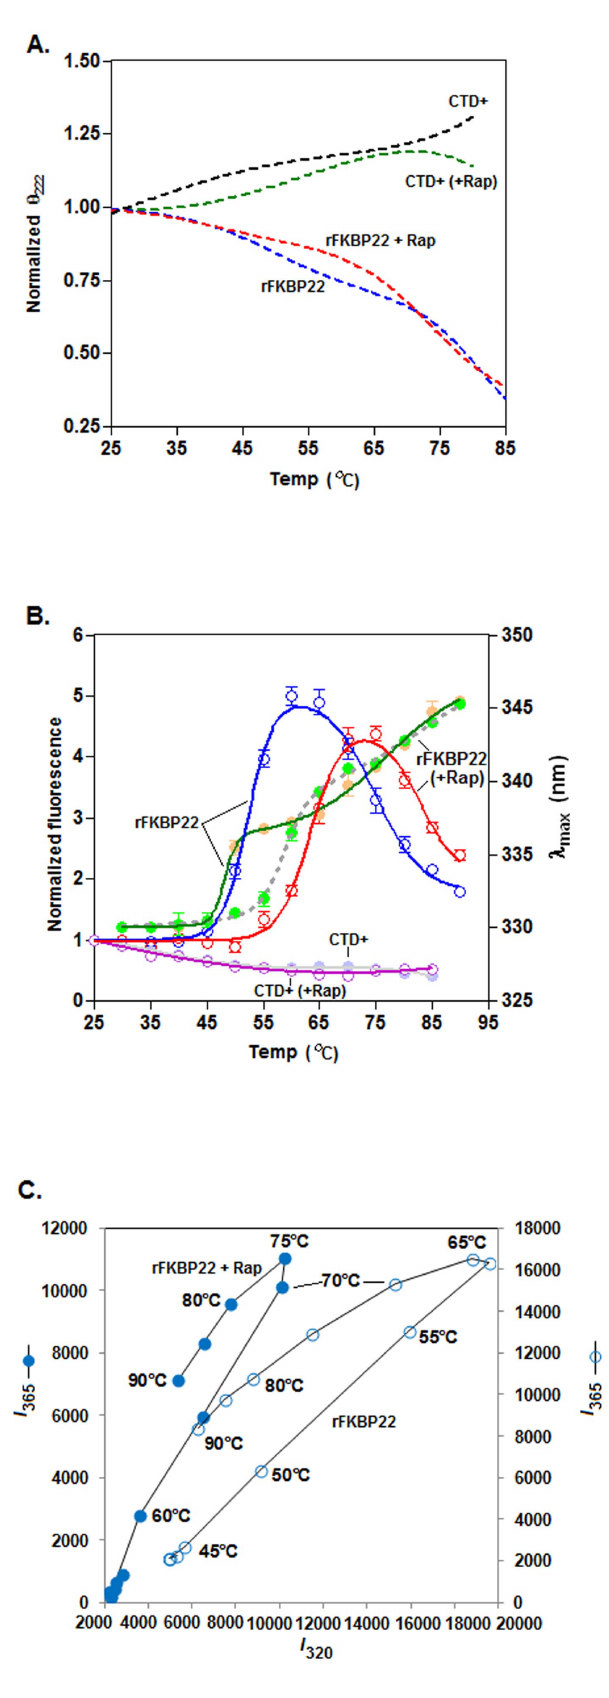
Figure 5. Thermal unfolding of of rFKBP22 and CTD + in the absence and presence of rapamycin. (A) The h 222 (ellipticity at 222 nm) values, obtained from the CD spectra of the indicated proteins (saturated with or without Rap) at 25 u –85 u /95 u C (Figures S7A–7D), were normalized with respect to that of the same at 25 u C. The resulting normalized h 222 values were plotted versus the related temperatures. All lines through the CD values are the best-fit curves. (B) The intrinsic Trp fluorescence intensity values at 330 nm (for rFKBP22 bound with or without rapamycin) and at 347 nm (for CTD + saturated with or without rapamycin) were similarly calculated from the Trp fluorescence spectra (Figures S7E–7H), normalized and plotted against the corresponding temperatures. The l max values associated with the rapamycin-equili- brated rFKBP22 and rFKBP22 at 25 u –90 u C were extracted too from the Trp fluorescence spectra (mentioned above) and plotted against the relevant temperatures. All lines through the fluorescence intensity or l max values are the best-fit curves. (C) Phase diagrams showing the unfolding of the indicated proteins at 25 u –90 u C. I 320 and I 365 denote the fluorescence intensity values (derived from Figures S7E–7H) of a protein at 320 nm and at 365 nm,